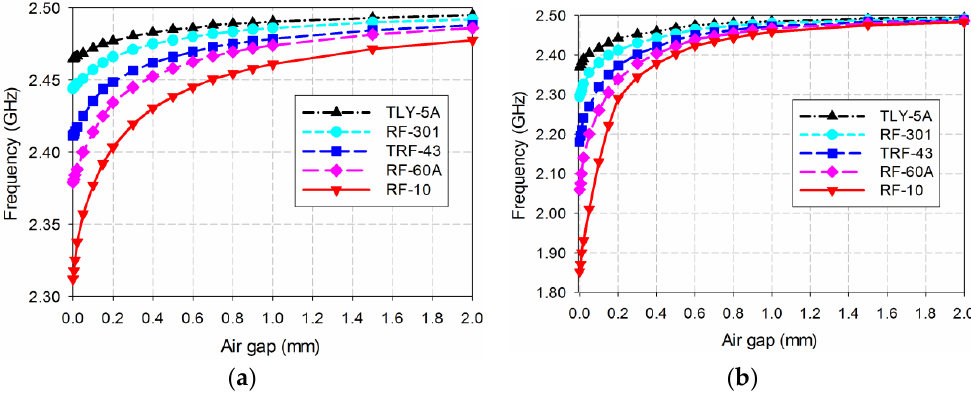
Figure 15. Variations on the resonant frequency of the conventional and proposed patch antennas when varying the air gap: ( a ) Conventional f r1 ; ( b ) proposed f r1 .